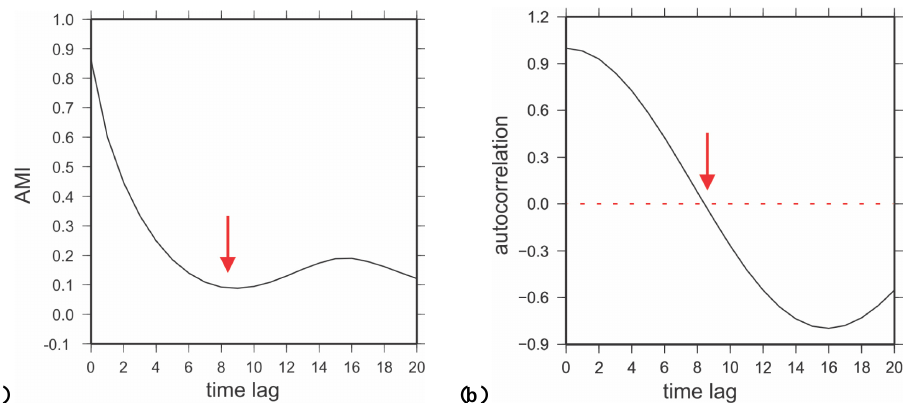
Fig. 4. Example of delay time selection for event #25. (a) shows the variation of average mutual information (AMI) as a function of time lag. The arrow highlights the first minimum of AMI. (b) shows the variation of the autocorrelation function as the time lag varies. The arrow shows the first zero crossing.